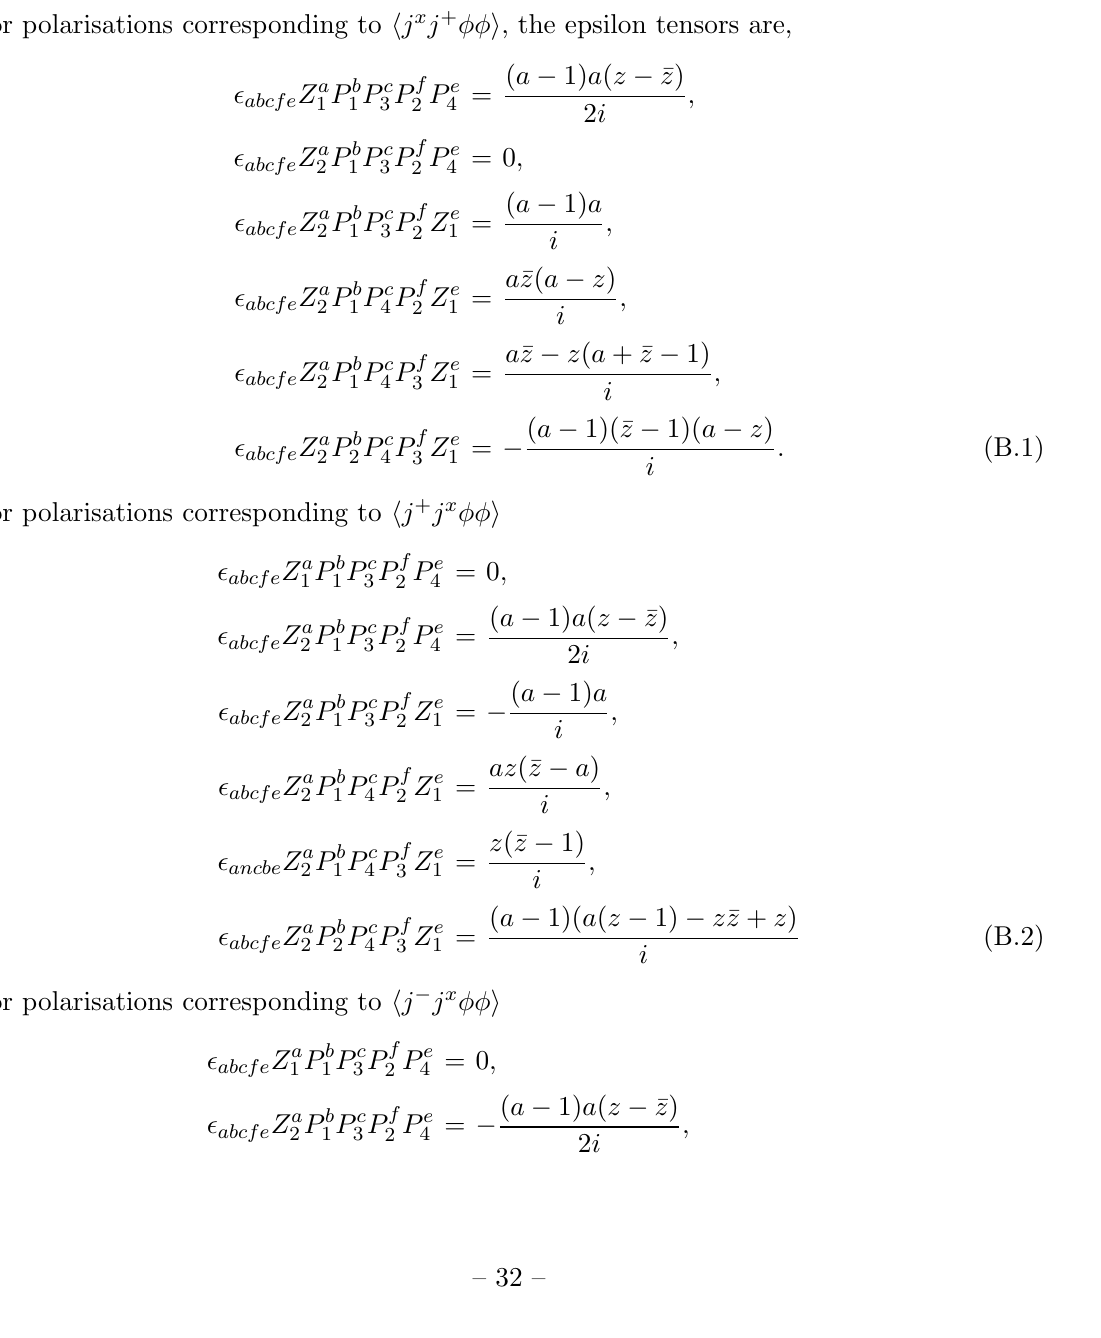
For polarisations corresponding to h j x j + (cid:30)(cid:30) i , the epsilon tensors are,